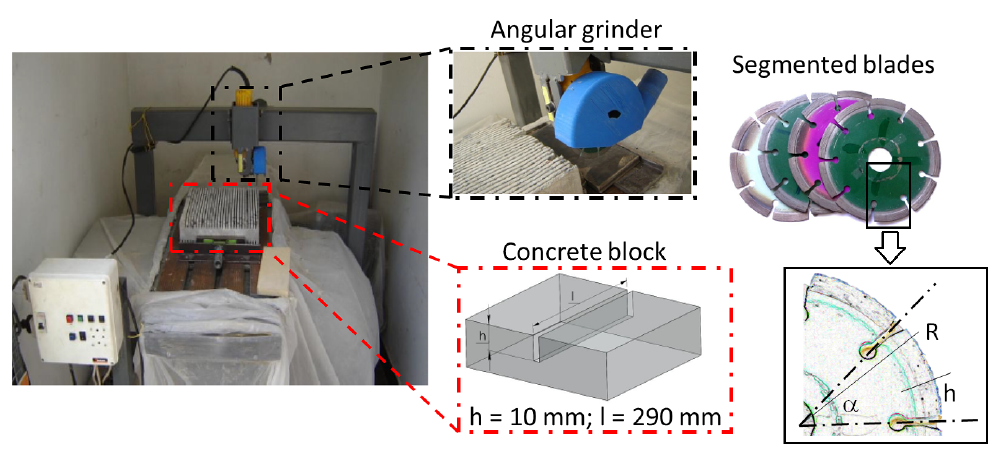
Figure 2. Cutting process of dry-concrete by using different segmented diamond blades in an in-house developed automatic